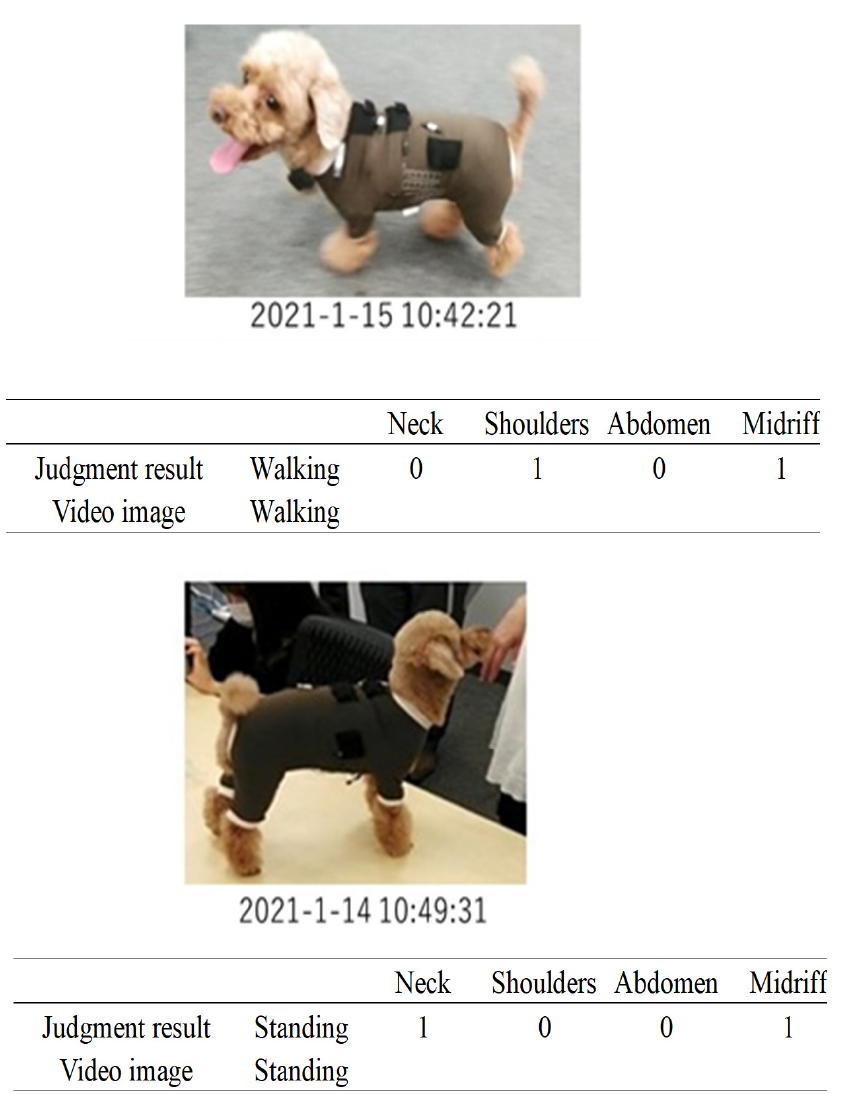
Figure 16. Example of match between the judgment result and the video image.